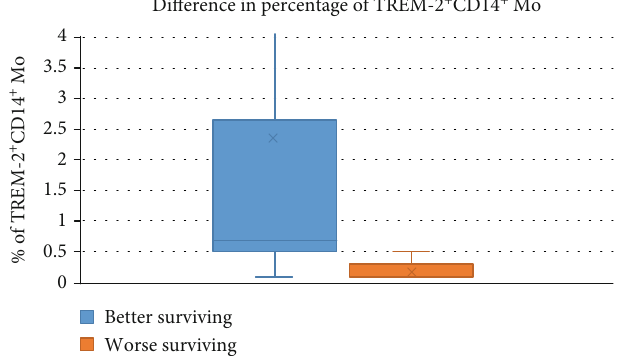
Figure 4: Percentage of CD14+ TREM-2+ monocytes in good and bad surviving patients in GBM – G. IV patients. Pts: patients.